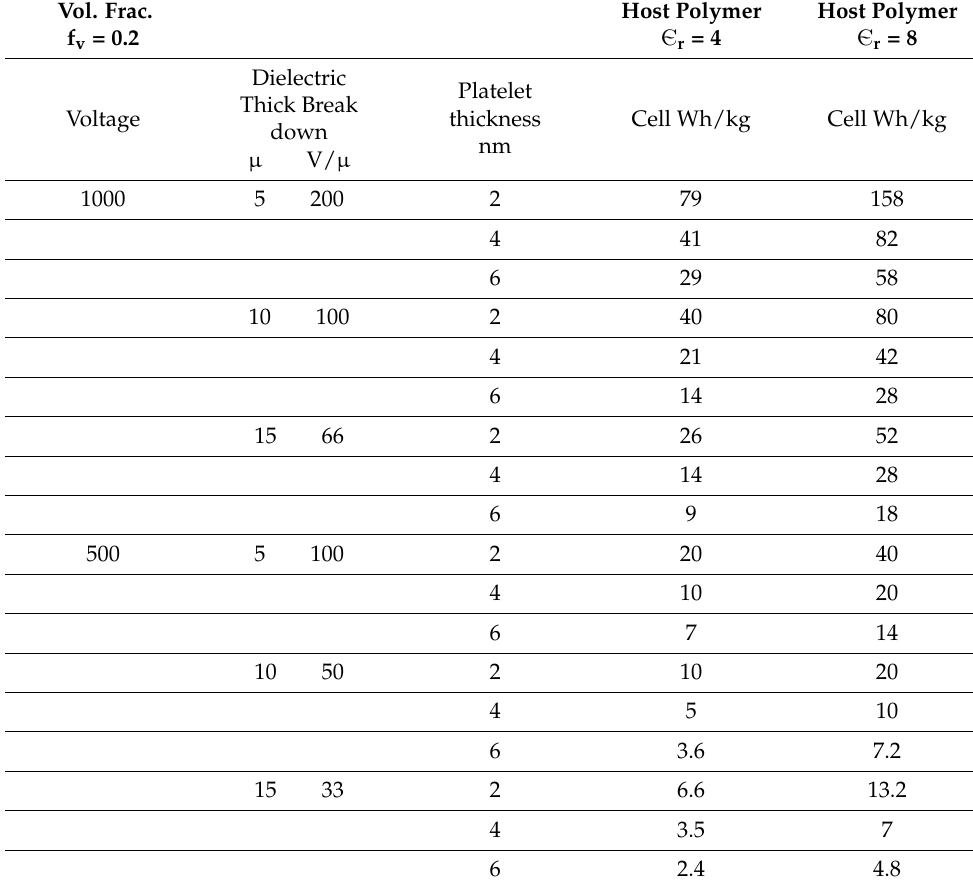
Table 4. Dielectric cell Wh/L using platelet graphene carbon elements and host polymer. Vol. Frac.